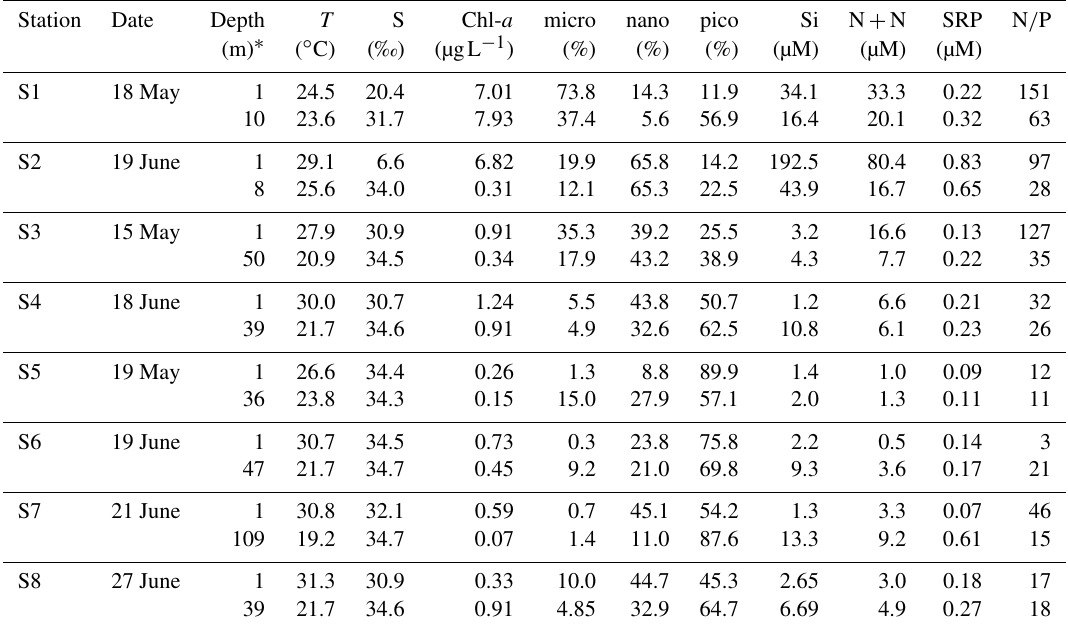
Table 1. Hydrographic and biogeochemical properties of the surface and bottom waters for incubations over the NSCS shelf during May and June 2016. Nutrient-addition experiments and water-mixing experiments were conducted immediately after we reached these stations.